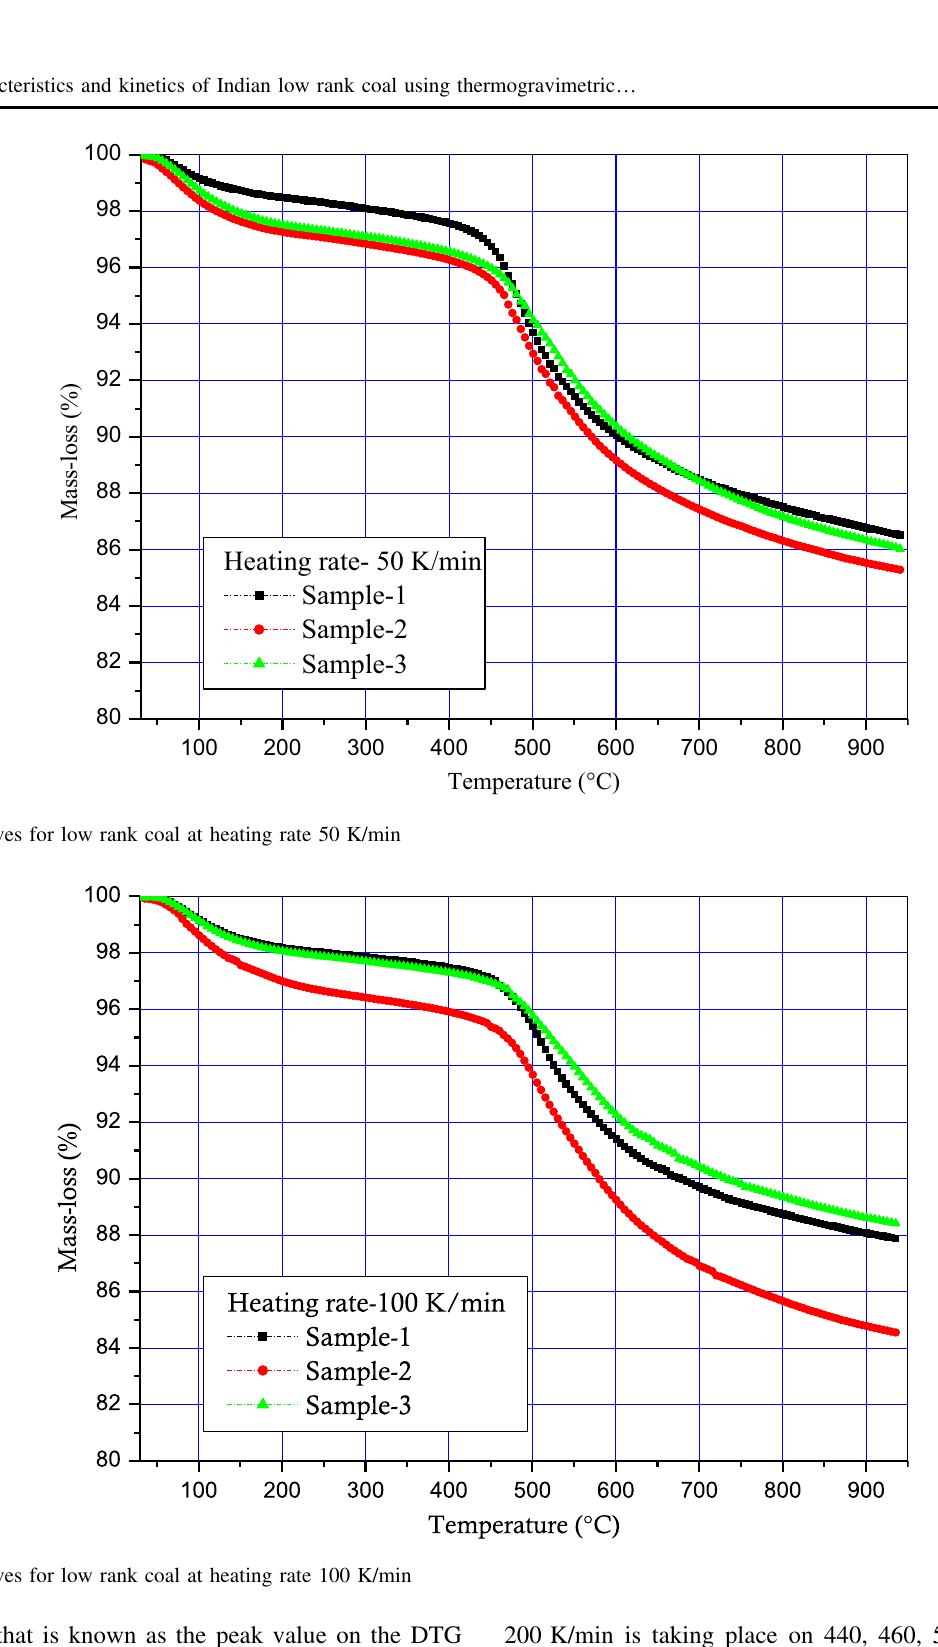
Fig. 2 TG curves for low rank coal at heating rate 100